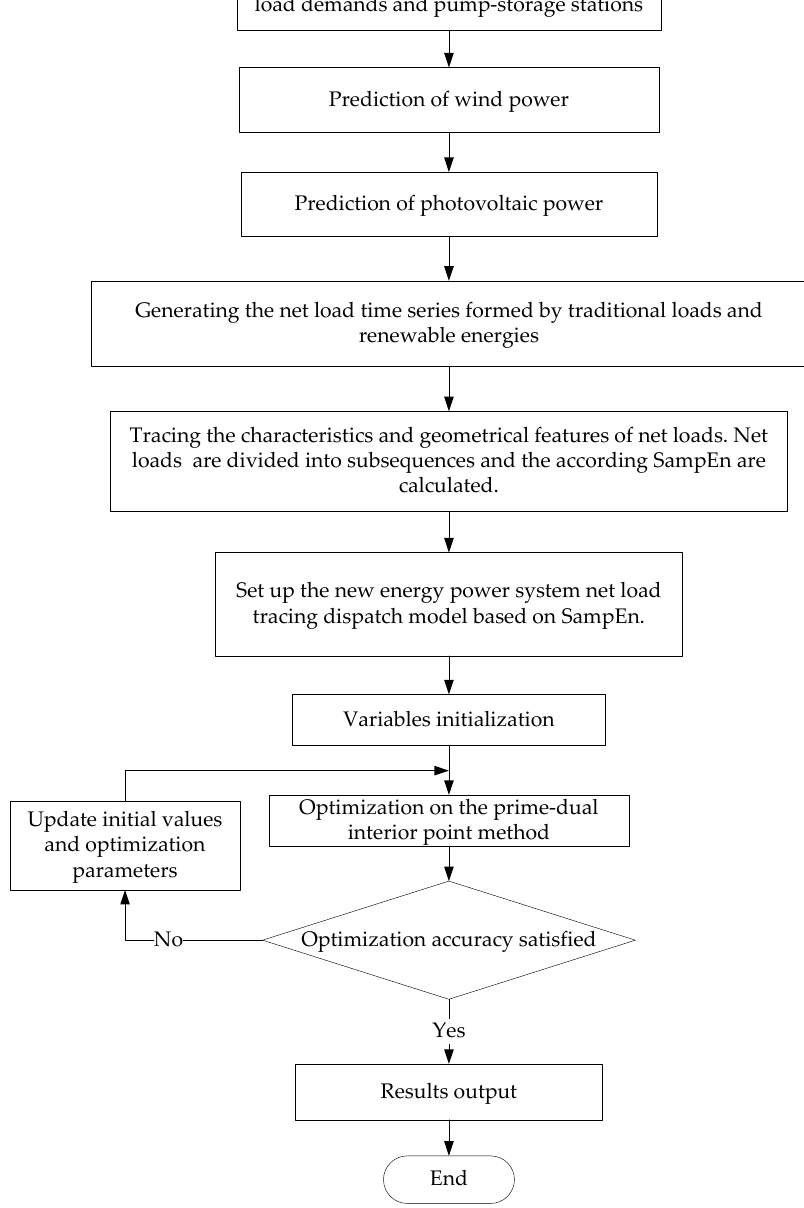
Figure 7. Flow chart of power system net load tracing dispatch based on sample entropy.